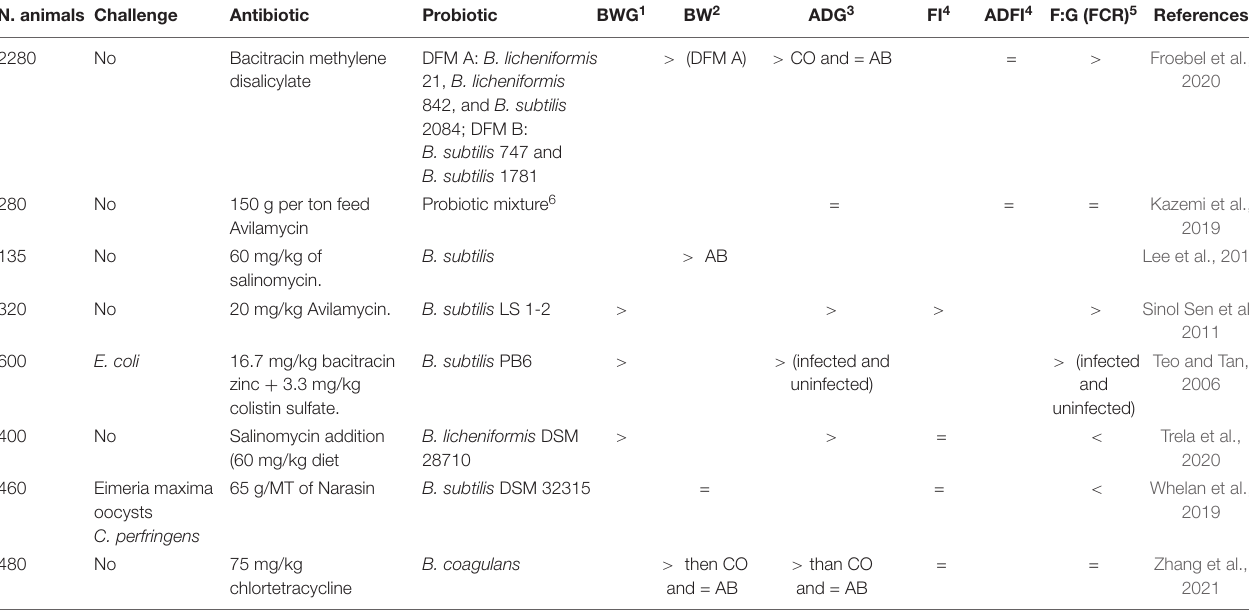
BWG 1 : Body weight gain; BW 2 : Body weight; ADG 3 : average daily gian; FI 4 : Feed intake; ADFI 4 : average daily feed intake; F:G (FCR) 5 : feed to gain ratio; Probiotic mixture 6 : E. faecium, L. delbruekii subp.bulgricus, L. acidophilus, L. plantarum, L. rhamnosus, Bifidobacterium bifidum, S. salivarius thermuphilus, Candida pintolopesii and Aspergillus